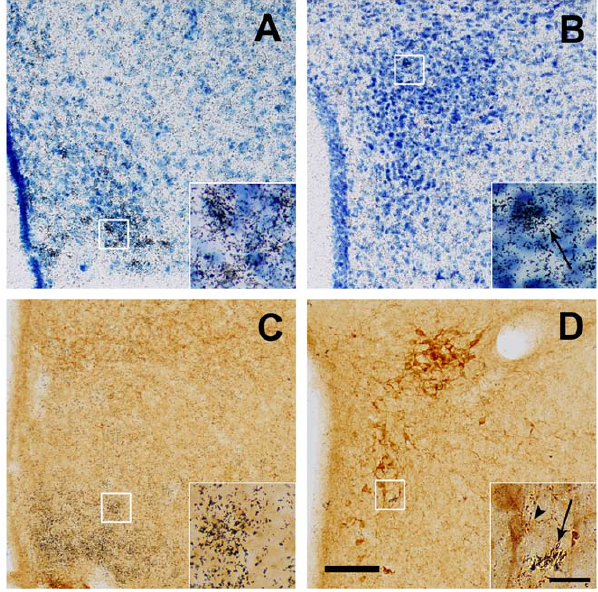
Figure 8. CRF-IR neurons of the PVN do not express GHSR. Upper panels show representative ISHH photomicrographs of thionin counterstained coronal sections of brain mouse. Panels A and B show photomicrographs of the ARC and PVN, respectively. Black silver granules, representing the binding of GHSR antisense riboprobes, can be detected at a higher density in the ARC (A) and with smaller density in the PVN (B). Bottom panels show representative photomicrographs of ISHH for GHSR (black silver granules) and IHC for CRF (brown staining) on coronal brain sections of mice. Panels C and D show photomicrographs of the ARC and PVN, respectively. Inserts in each image show high magnification of areas marked in low magnification images. White arrows point to examples of cells labeled with GHSR riboprobe. Black arrowhead point to examples of cells labeled with anti- CRF IHC. Scale bars, 100 m m (low magnification), 20 m m (high magnification).